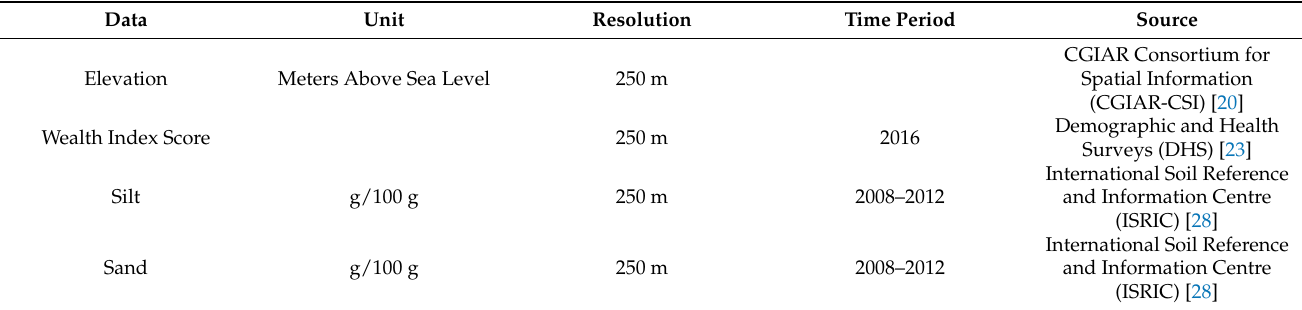
Table 1. Environmental and ecological variables, and data